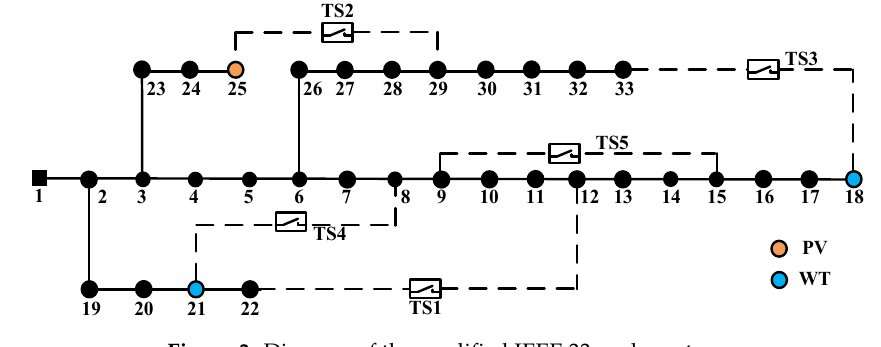
Figure 2. Flowchart of the proposed decentralized control strategy of SOPs.